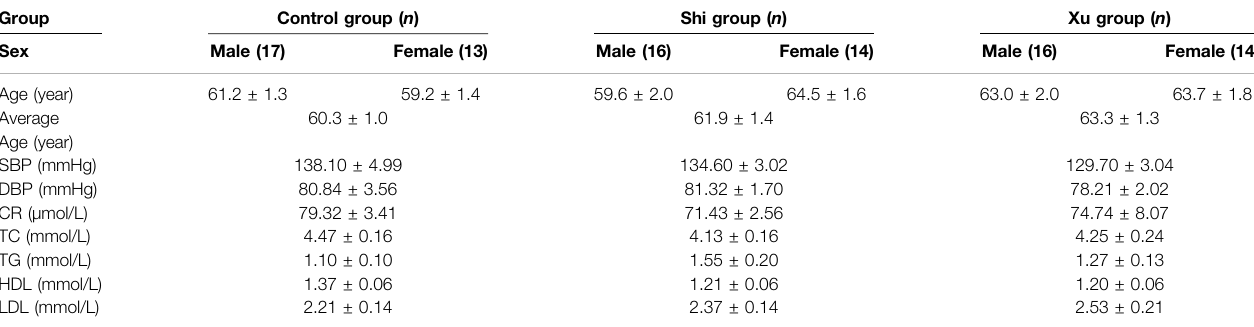
TABLE 1 | Participants included in the control, Shi-subtype and Xu-subtype groups.